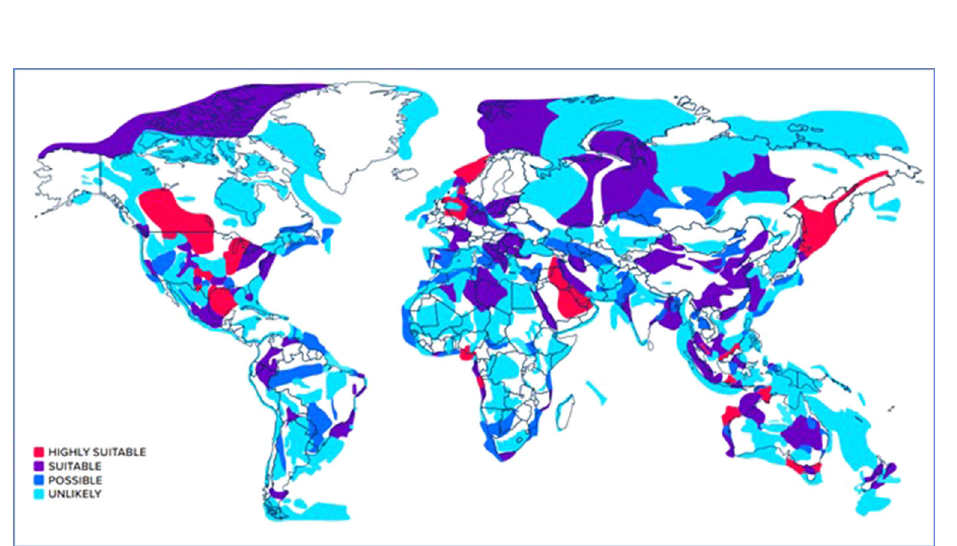
Fig. 7. – Suitable storage regions of the world based on the Global CCS Institute’s storage basin assessment database [2].